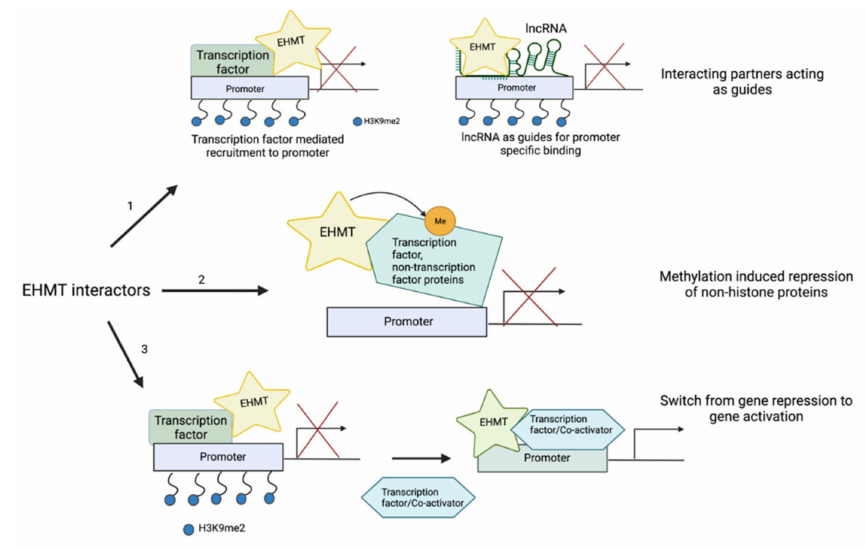
Figure 2. Impact of EHMT-interacting proteins. (1) Transcription factors and lncRNA can bind to EHMTs and guide them to the promoter of target genes to suppress gene transcription. (2) EHMTs can methylate their binding partners, rendering them functionally inactive. (3) Upon binding to specific interactors, EHMTs can function to activate transcription. Table 2. EHMT-interacting proteins in distinct cancer types. The roles and potential therapeutics are